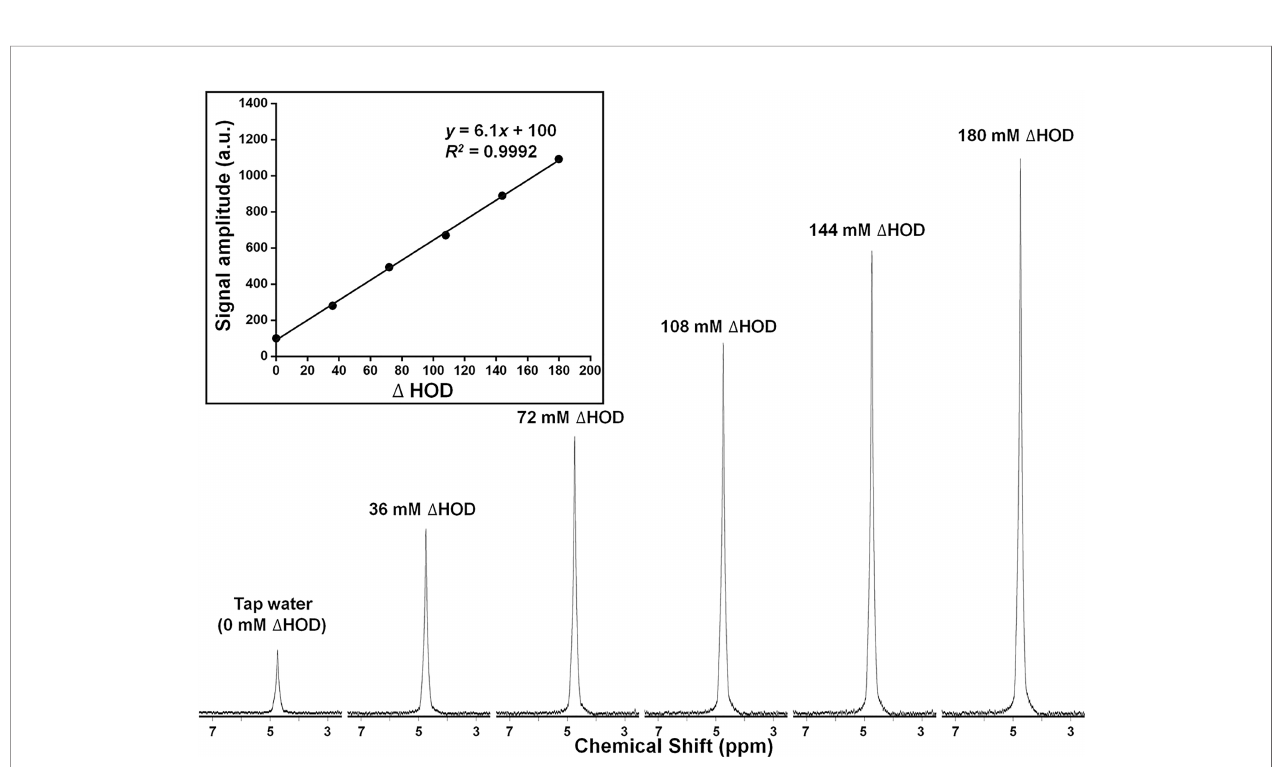
FIGURE 6 | Deuterium ( 2 H = D) MR spectra and (inset) plot of signal amplitude (arbitrary units), for a series of HOD samples of increasing 2 H concentration. 2 H concentration ( D HOD) is expressed relative to that of tap water.